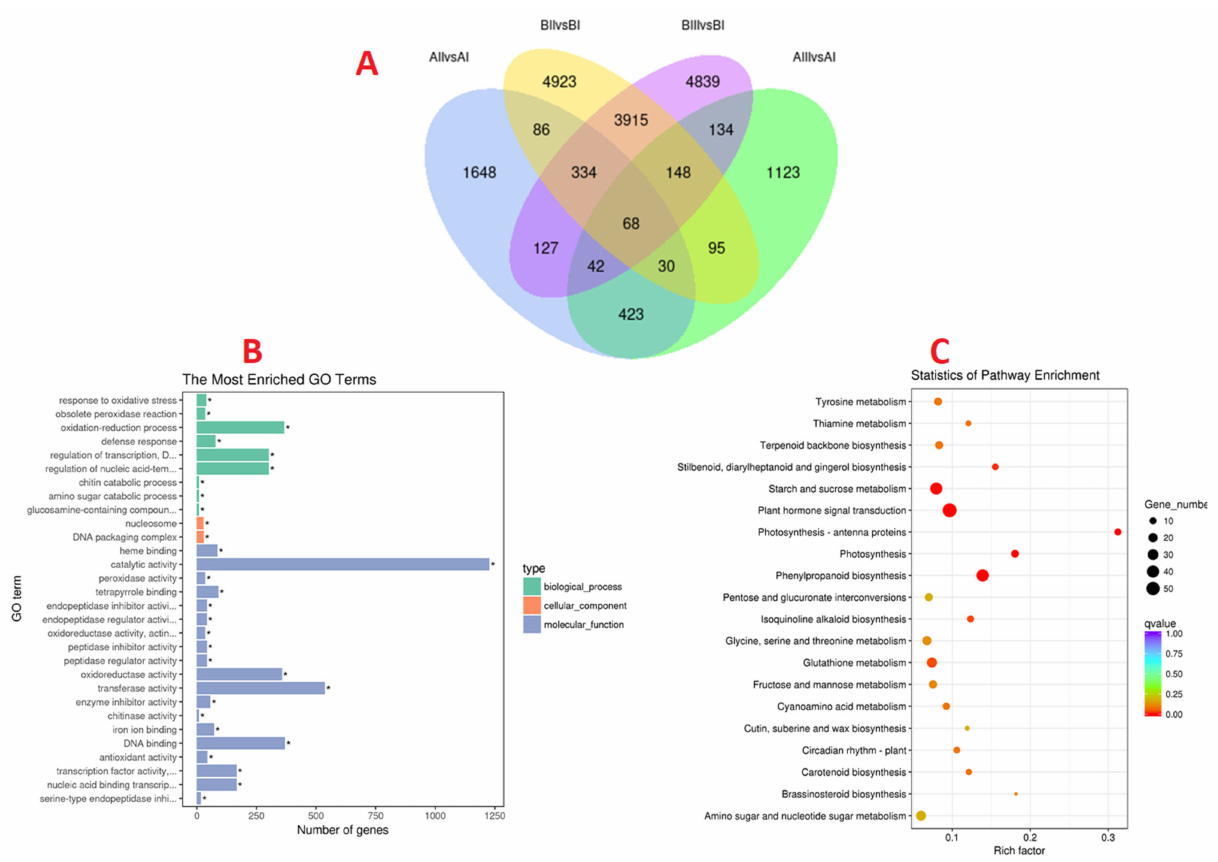
Figure 2. ( A ) Venn diagram of DEGs among the four comparisons performed (AII vs. AI, AIII vs. AI, BII vs. BI and BIII vs. BI). AI—vertical (control) group after 20 days of planting; AII—horizontal group after 20 days of planting; AIII—slant group after 20 days of planting; BI—vertical (control) group after 50 days of planting; BII—horizontal group after 50 days of planting; BIII—slant group after 50 days of planting. ( B ) GO (Gene ontology) classification histogram of the DEGs. “*” represents significant enrichment ( p < 0.05). ( C ) Bubble chart of the DEGs enrichment